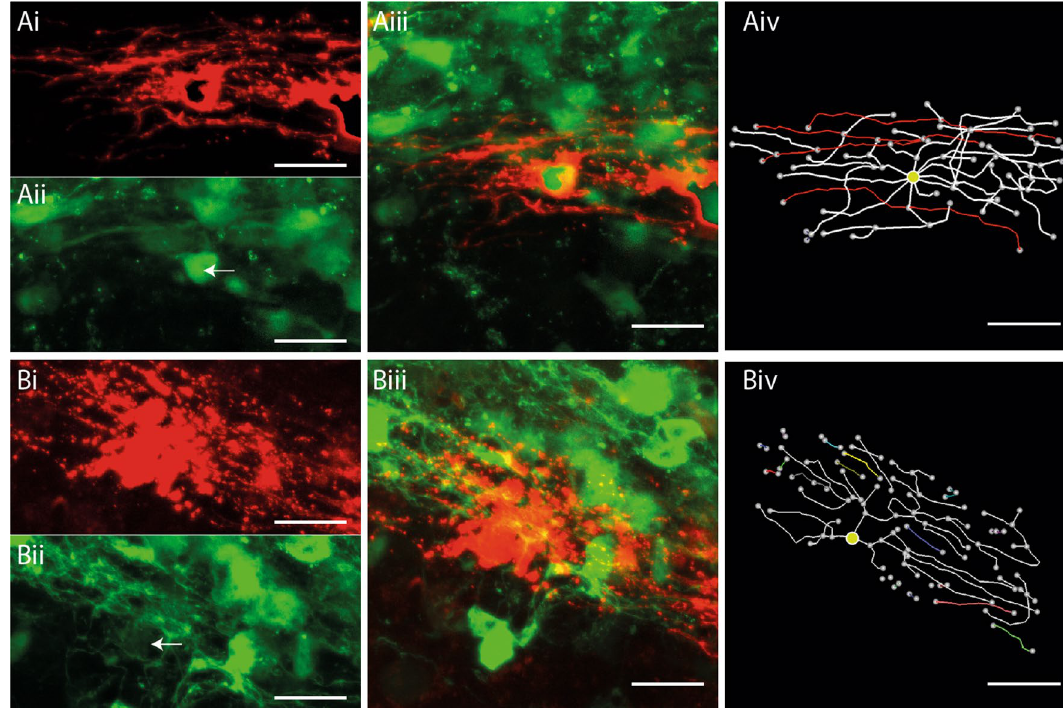
Figure 4. Complement mediated injury destroys internodes on SFV labelled OL. ( A ) Reconstruction of an SFV labelled OL expressing the CNPase-GFP transgene in a complement control treated slice. ( Ai ) mCherryMBP fluorescence reveals an OL with a typical myelinating morphology. ( Aii ) CNPase-GFP signals imaged from the field shown in ( Ai ) (white arrow indicates position of the mCherry + OL). ( Aiii ) Merged image of the field shown in ( Ai-ii ) confirms co-localisation of mCherry (red) and CNPase-GFP (green) signals. ( Aiv ) 3-D reconstruction and analysis reveals 4 internodes (red) on the OL shown in ( Ai – iii ). ( B ) Morphological analysis of an A774 labelled OL following complement injury. ( Bi ) mCherry-f labelled OL with degenerating processes. ( Bii ) CNPase-GFP signals imaged from the field shown in ( Bi ). White arrow indicates position of mCherry + OL shown in ( Bi ). ( Biii ) Merged image reveals localization of mCherry (red) and CNPase-GFP (green) signals. ( Biv ) Reconstruction and analysis of the cell shown in ( Bi – iii ) reveals fragmented processes (coloured segments) and the absence of internodes. Yellow circles indicate position of cell body. Scale bars in ( A ) and ( B ) 20